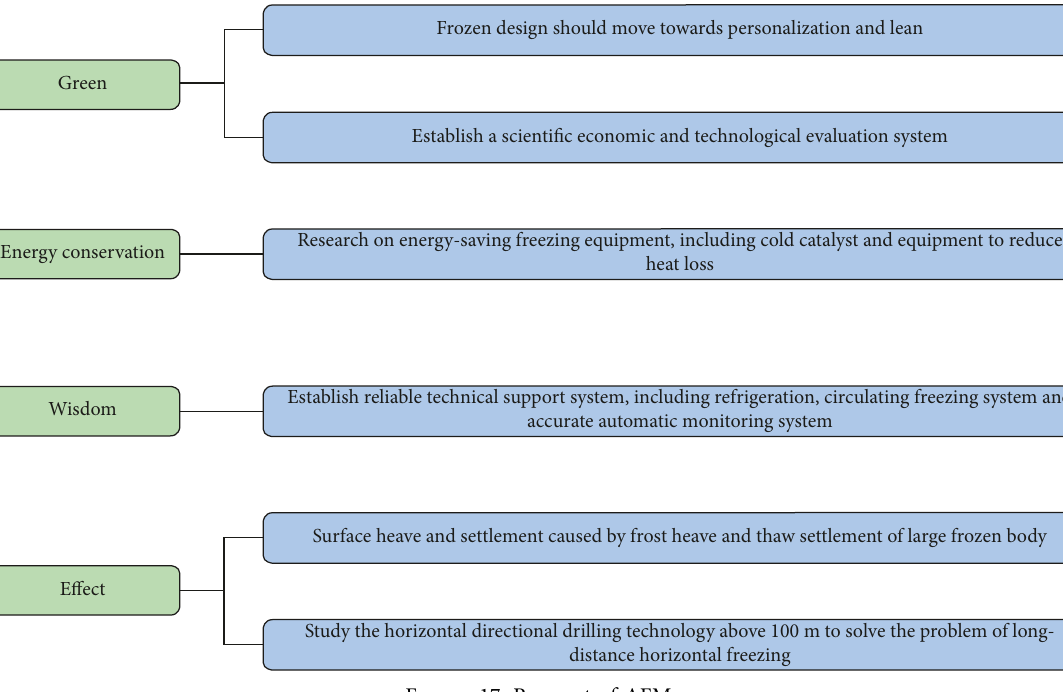
Figure 17: Prospect of